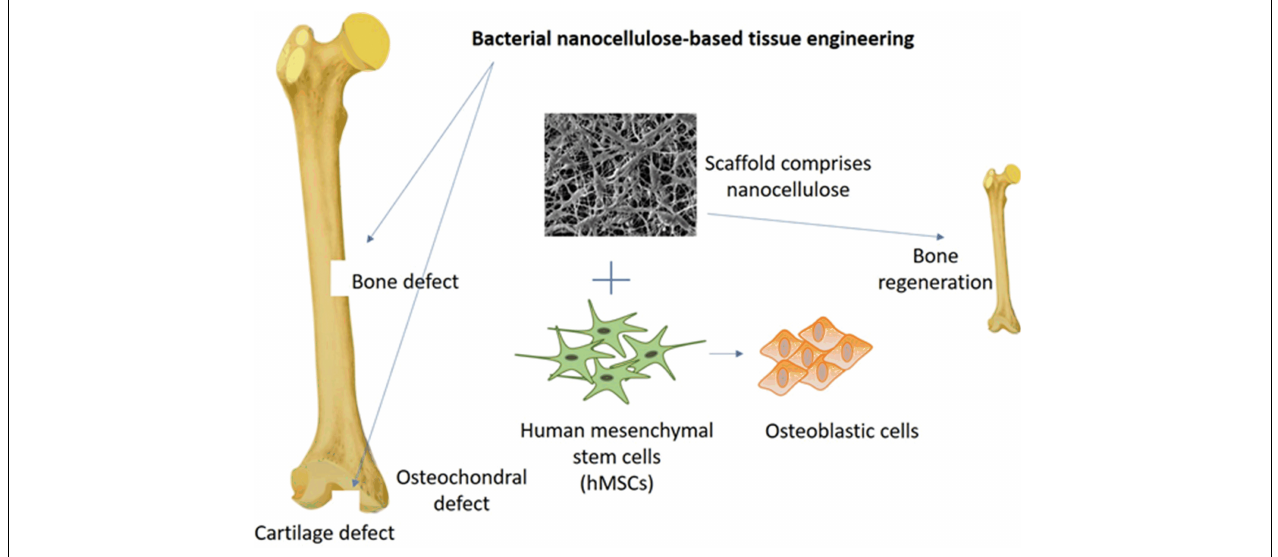
FIGURE 1 | Bone regeneration concept conducted by the synergistic effect of hMSCs cells and BNC-based scaffold. The scaffold allowed the differentiation of hMSCs into the